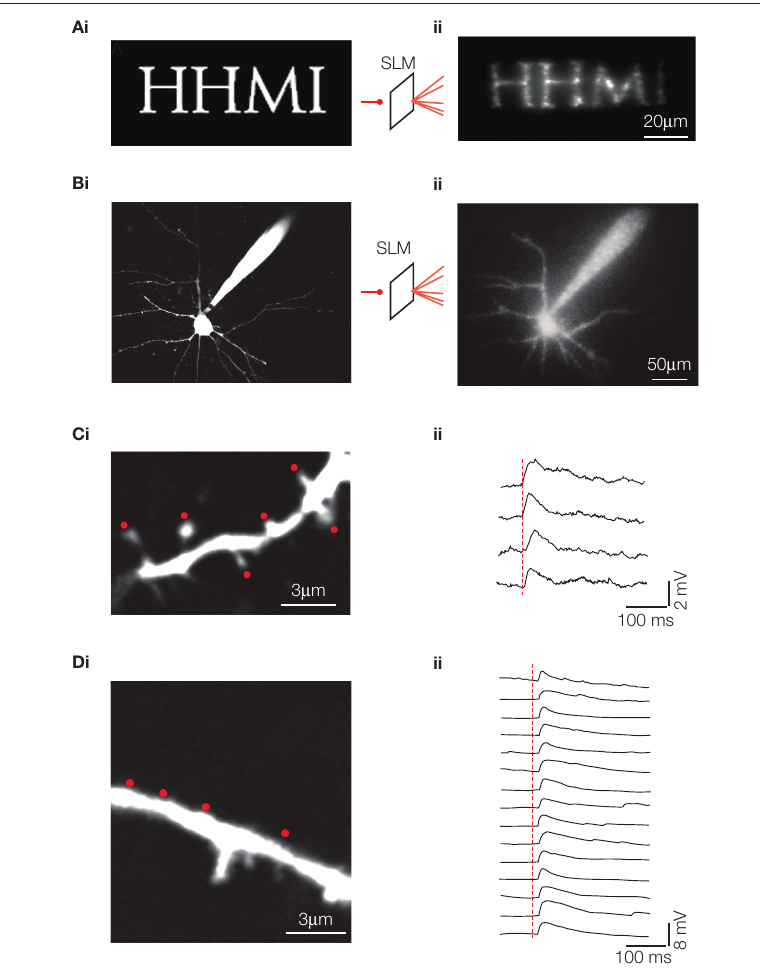
Figure 3 | Spatial light modulator (SLM) two-photon imaging and photostimulation. (Ai) Arbitrary pattern of desired output from SLM in the shape of letters “HHMI”. (Aii) Pattern by SLM from a single circular input beam, projected through 60 × 0.9NA objective into agar block filled with Alexa 488 fluorescent dye. (Bi) Similar to (Ai) , however more complex desired output pattern of output from SLM in the shape of a patch clamped neuron. This image was thresholded and binarized to create a final output template. (Bii) SLM-created pattern projected into Alexa 488-filled agar block under 40 × 0.8NA objective. (Ci) Basal dendrite from a layer 5 pyramidal neuron in an acute slice of mouse neocortex. The neuron is loaded with Alexa-488 and the slice bathed in MNI-glutamate. The SLM was used to create a diffraction pattern placing beamlets adjacent to individual spines of the dendrite (red dots). Pulses of excitation light delivered simultaneously at these points using the SLM triggered uncaging of MNI-glutmate. (Cii) Whole cell patch clamp recording at cellular soma of integrated potentials created by simultaneous uncaging at the spots indicated. Each horizontal trace represents a repetition of the stimulation and reveals the uncaging potentials recorded at the soma. (Di) Similar to (C) , however now in a new neuron with uncaging targeted to locations near a dendritic shaft rather than near spines. (Dii) Patch clamp recordings of multiple trials of multi-point simultaneous uncaging revealing the uncaging potentials recorded at the soma. See Nikolenko et al. (2008) for more detailed description of the methods used for these